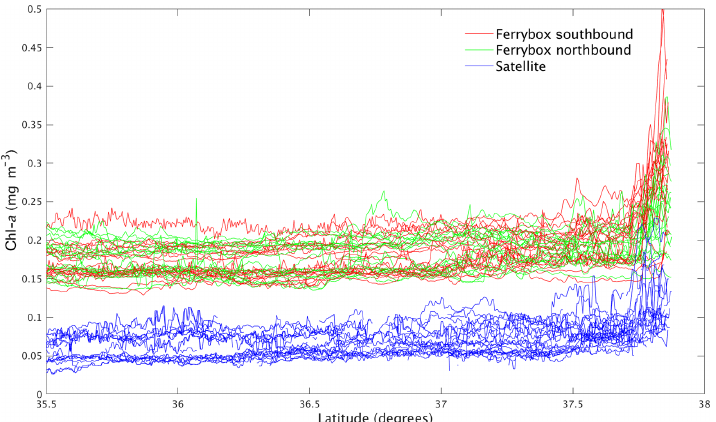
Figure 8. Comparison of POSEIDON Ferrybox’s fluorescence data with satellite ocean colour data over a selected period (October 2017 to January 2018). FB data are separated depending on the direction of the vessel (green lines: southward towards Heraklion; red lines: northward towards Piraeus). Satellite data were obtained from the OCEANCOLOUR_MED_CHL_L3_REP_OBSERVATIONS_009_073 product available at http://marine.copernicus.eu/services-portfolio/access-to-products/ (last access: 26 September 2018).